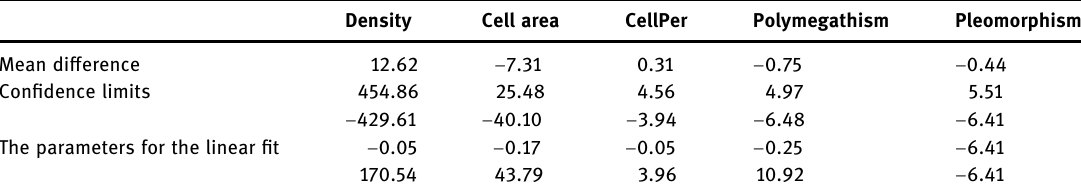
Table 2: Mean di ff erence, con fi dence limits, and the parameters for the linear fi